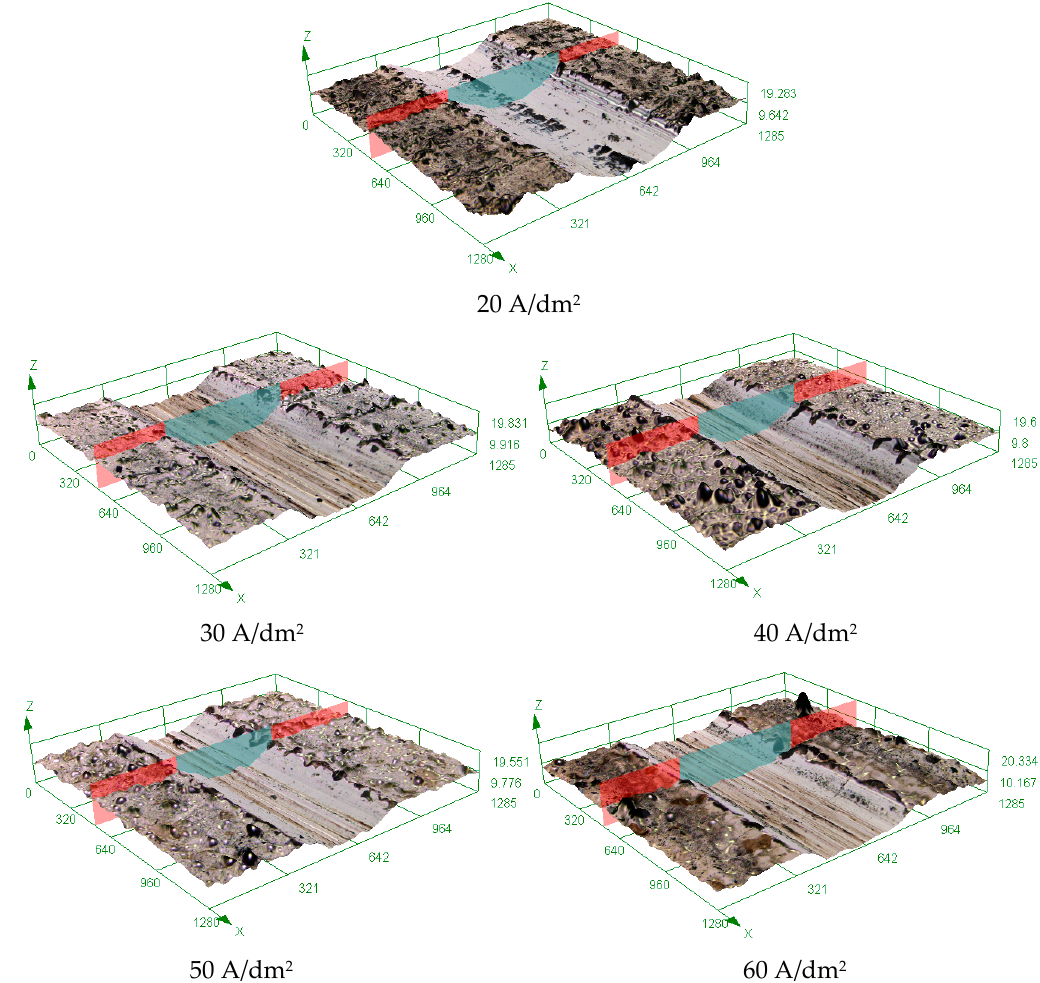
Figure 8. Cross-sectional morphologies of wear scars on composite coatings at different current densities. Table 4. Section parameters of wear scars on composite coatings under different current